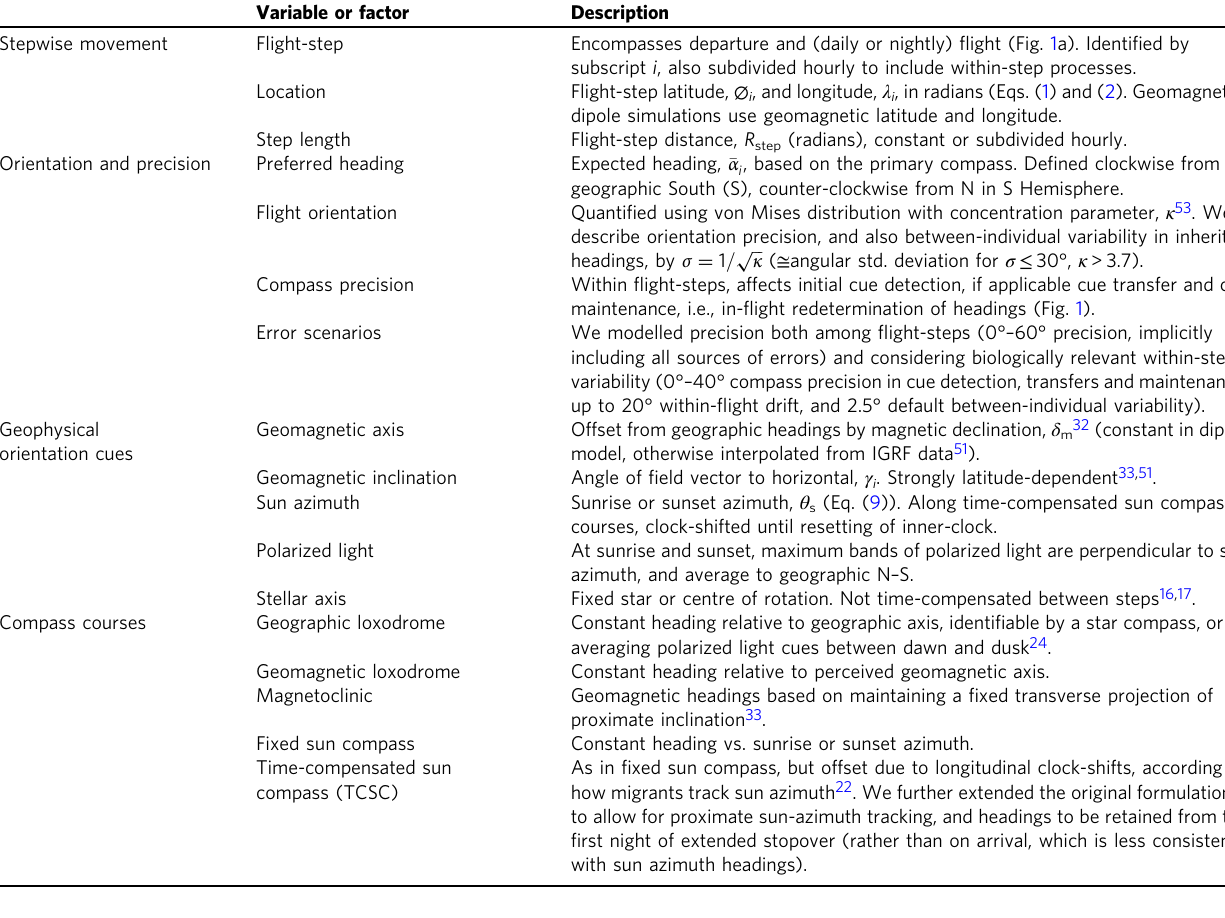
Table 1 De fi nitions of terms describing stepwise movement, among and within-step precision, and geophysical orientation cues.